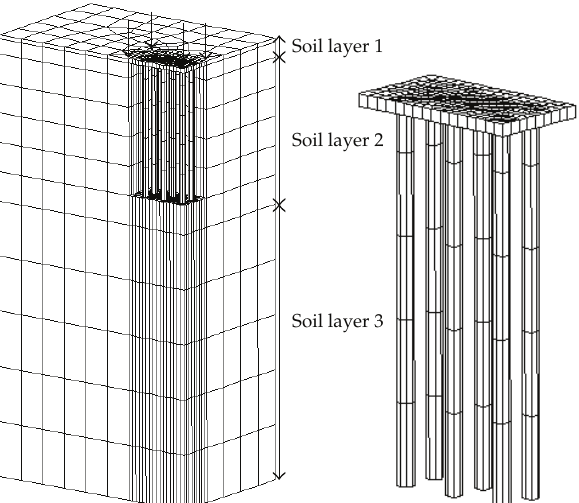
Figure 2: The finite element mesh of heterogeneous pile-group example.